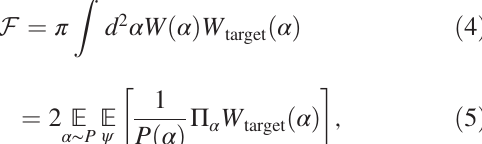
For the blue curves, the fidelity F is used as a reward, representing the expected performance in the limit of infinite averaging. (d) Evaluation of the training progress for the binomial ffiffiffi p ∝ 3 code state j ψ j 3 i þ j 9 i , whose Wigner function is target i shown in the